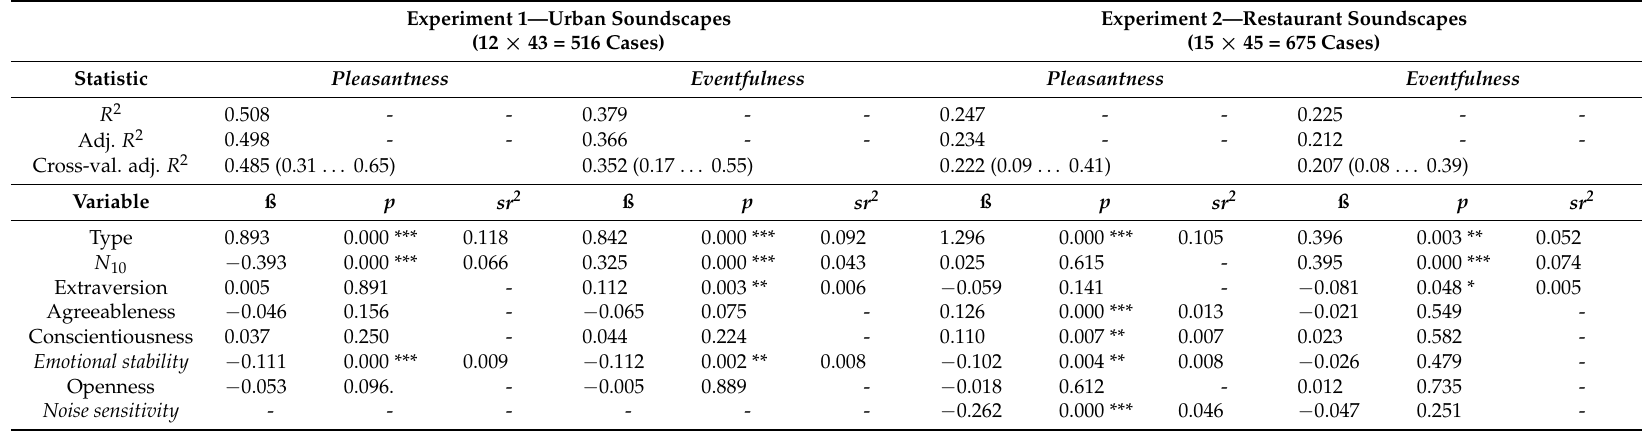
Table 6. Regression analysis results for Experiment 1 and 2. R 2 = amount explained. Adj. R 2 = R 2 adjusted for the number of predictor variables. Cross-val. adj. R 2 = mean 10-fold cross-validated adjusted R 2 across 3000 iterations [52], with 95% confidence interval around the mean in parenthesis. ß = standardized beta coefficient. p = probability value. sr 2 = squared semipartial correlation. Note that since type is a dummy encoded categorical variable, the numerical values given are for the pair of levels that was associated with the largest shift in the dependent variable. * p ≤ 0.05, ** p ≤ 0.01, *** p ≤